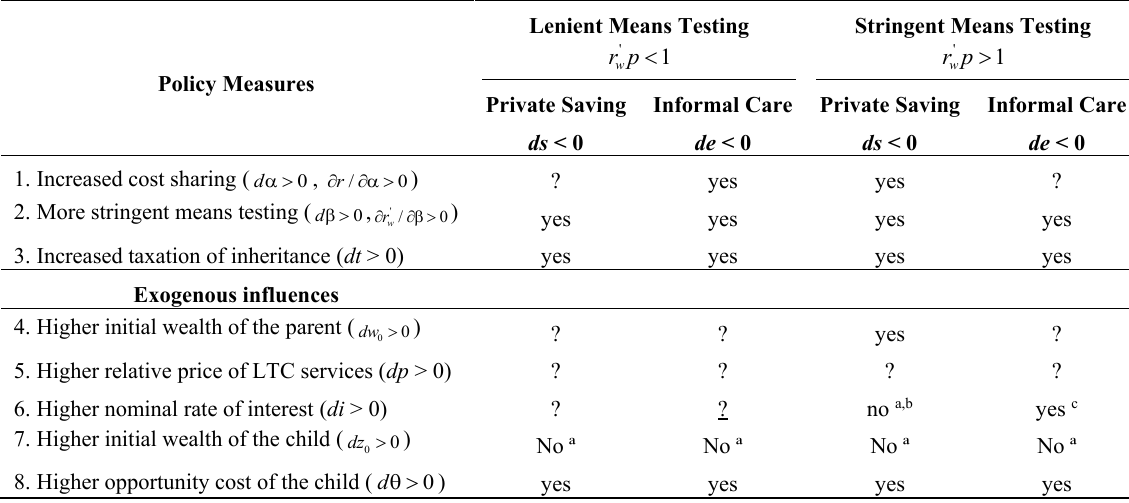
Table 1. Predicted instances of crowding